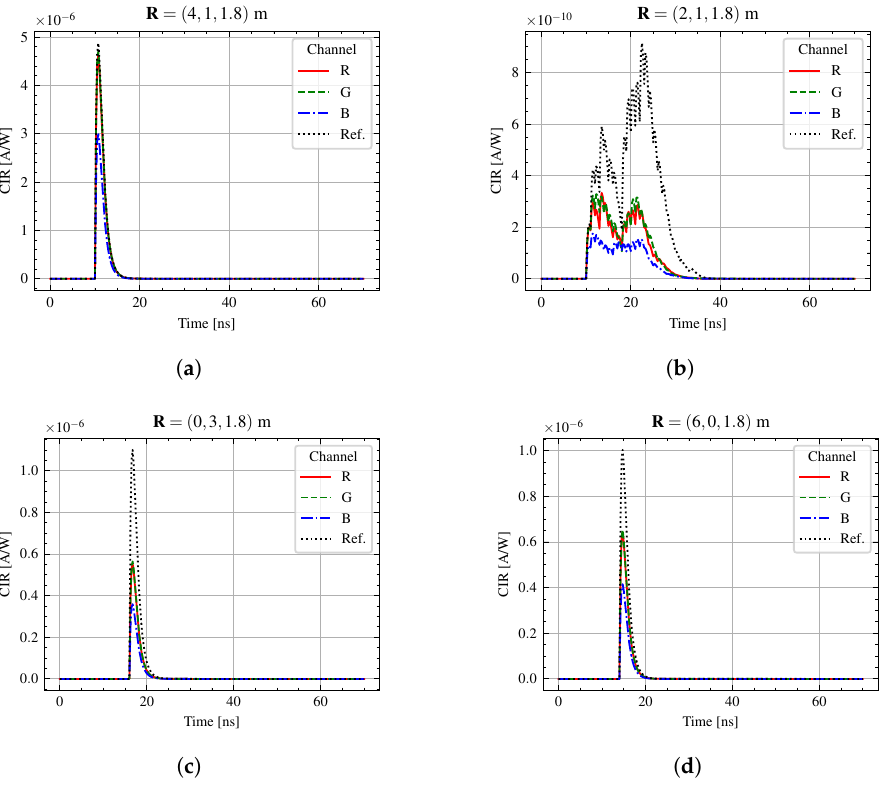
Figure 8. Channel impulse response. Label “R” is for h [ 1,1 ]( t ) , “G” is for h [ 2,2 ]( t ) , “B” is for h [ 3,3 ]( t ) , and “Ref.” is for R ref h ref ( t ) . RX position at ( a ) R 1 = ( 4,1,1.8 ) m, ( b ) R 2 = ( 2,1,1.8 ) m, · ( c ) R 3 = ( 0,3,1.8 ) m, ( d ) R 4 = ( 6,0,1.8 )